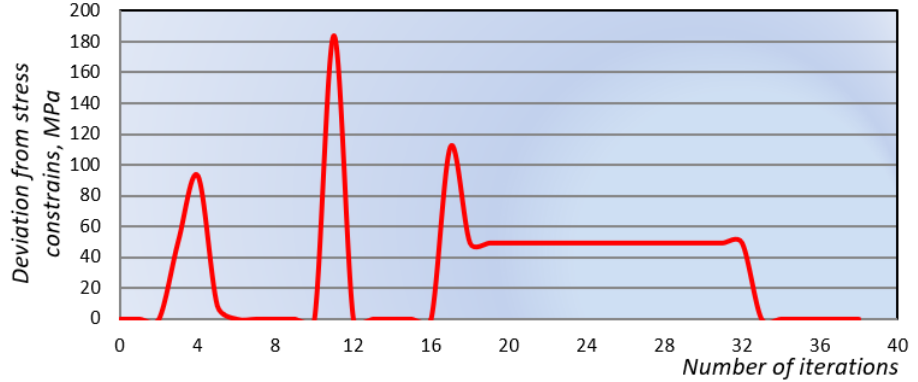
Figure 16. Reduction of displacement of proximal bone segment (D p ) during optimization process.